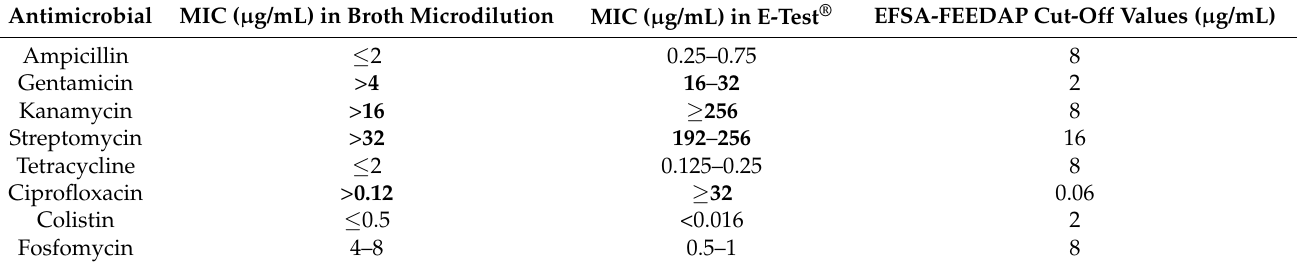
Table 1. Phenotypic antimicrobial susceptibility profile of Akkermansia muciniphila DSM 22959. Antimicrobial MIC ( µ g/mL) in Broth Microdilution MIC ( µ g/mL) in E-Test ® EFSA-FEEDAP Cut-Off Values ( µ